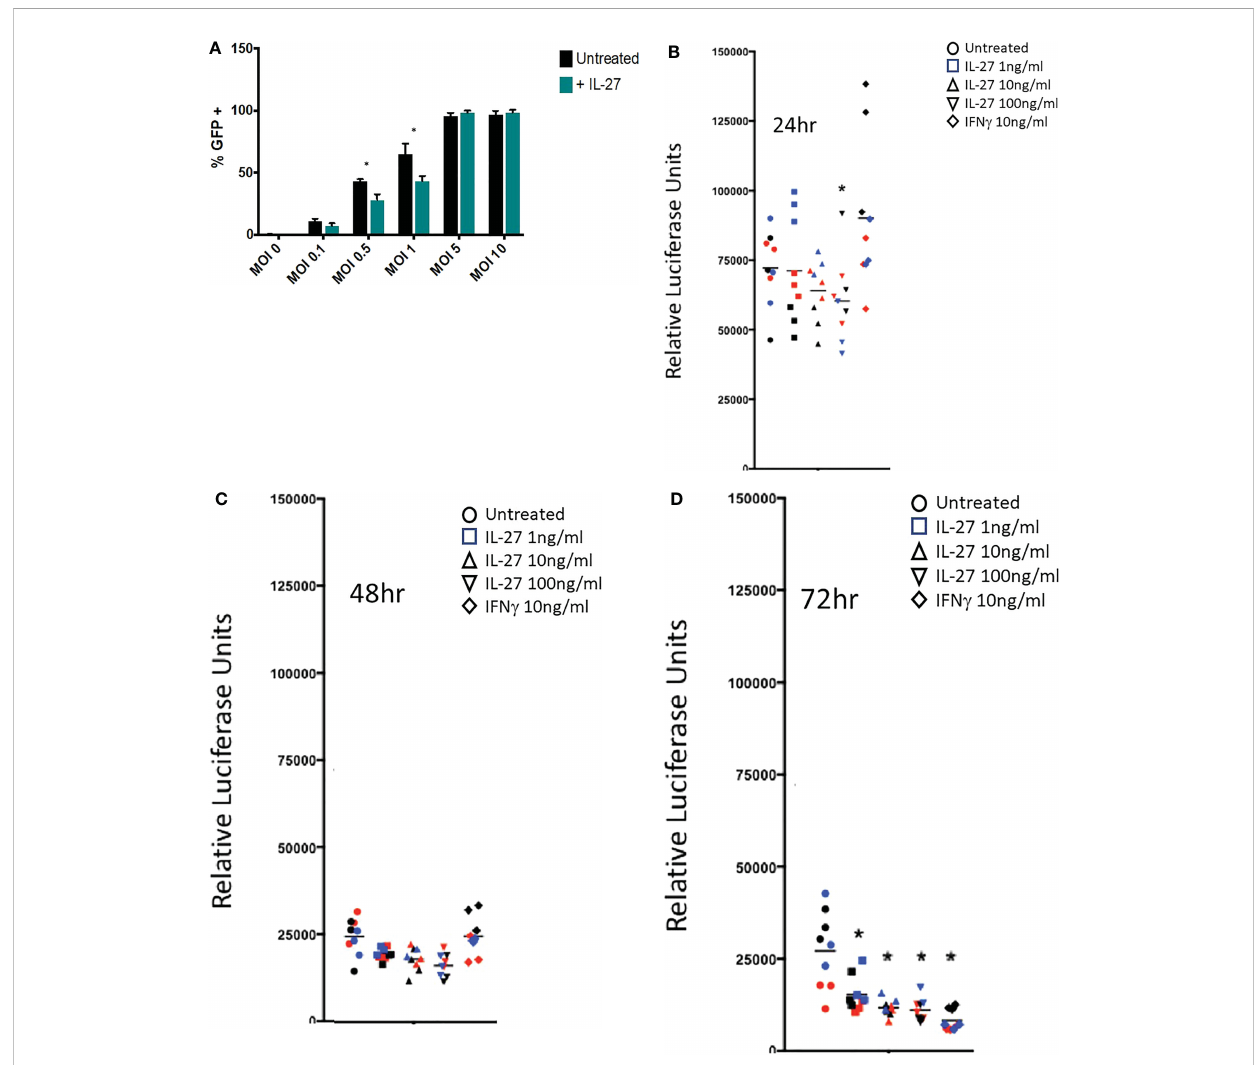
FIGURE 5 IL-27 treatment elicits antiviral activity against vaccinia and cytomegalovirus in murine macrophages. (A) Infection of resident macrophages with GFP-expressing vaccinia virus at six multiplicities of infection (MOI). IL-27 reduced viral infection of macrophages at 0.5 and 1 MOI. Graph depicts mean + SD of values from triplicate samples (B-D) . A luciferase-reporter mouse cytomegalovirus was used to infect macrophages in the presence of different IL-27 concentrations or IFN g as a positive control. Supernatants were harvested at 24, 48 or 72h and used to infect a highly MCMV permissive fi broblast cell line as a measure of active virus release from infected macrophages. Luciferase activity in the supernatant of infected macrophages was evaluated at 18h post fi broblast infection. Data representative of three independent experiments are shown in three colors. *p<0.05 by two-way